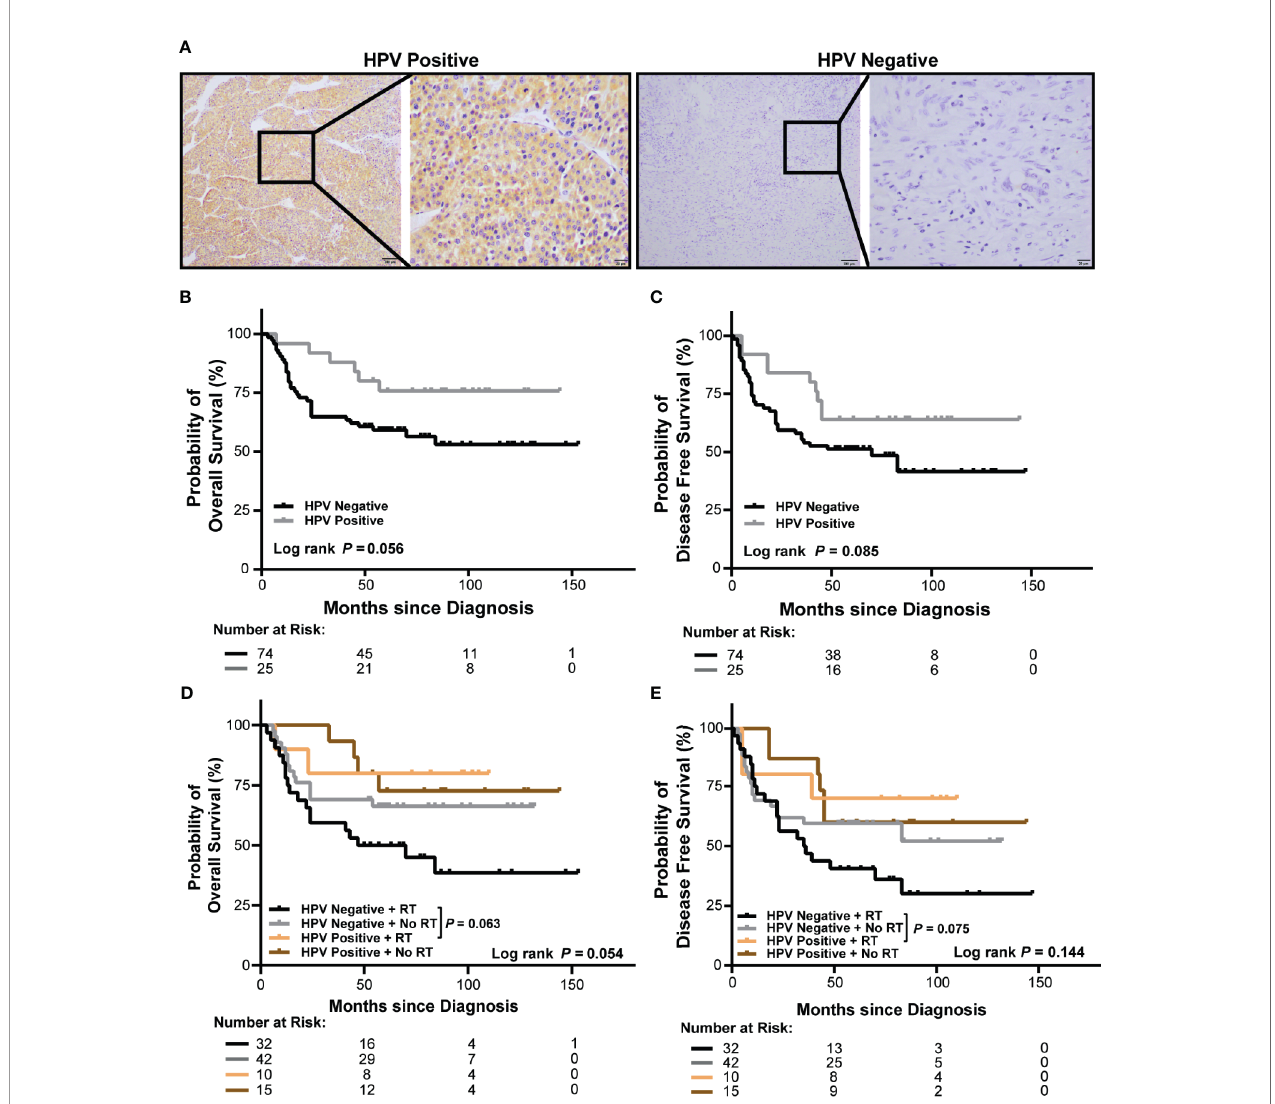
FIGURE 2 | Association of HPV status and radiation with survival of OSCC patients in our cohort. (A) Representative immunohistochemical images of p16 positive and negative OSCC (left: 100×, right: 400×). (B, C) Kaplan-Meier curves show overall survival (B) and disease-free survival (C) of HPV negative and HPV positive OSCC patients. (D, E) Kaplan-Meier curves show overall survival (D) and disease-free survival (E) of HPV negative and HPV positive OSCC patients receiving radiation or no radiation. Log-rank test and/or pair wised comparison was used for signi fi cance. RT,